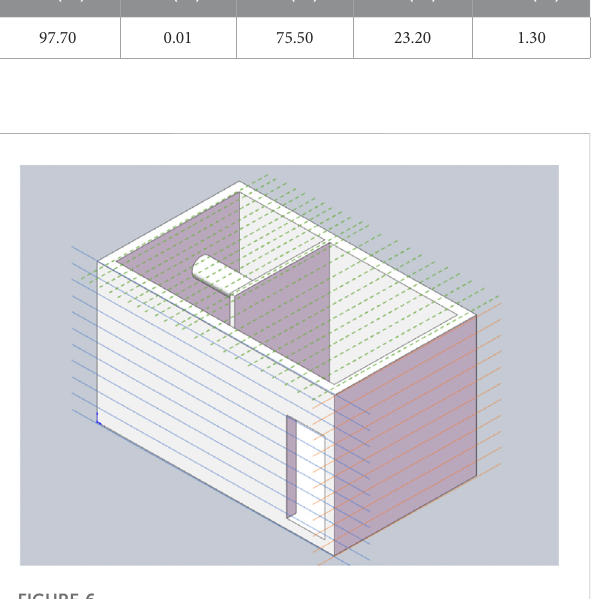
FIGURE 6 Schematic diagram of mesh distribution in the